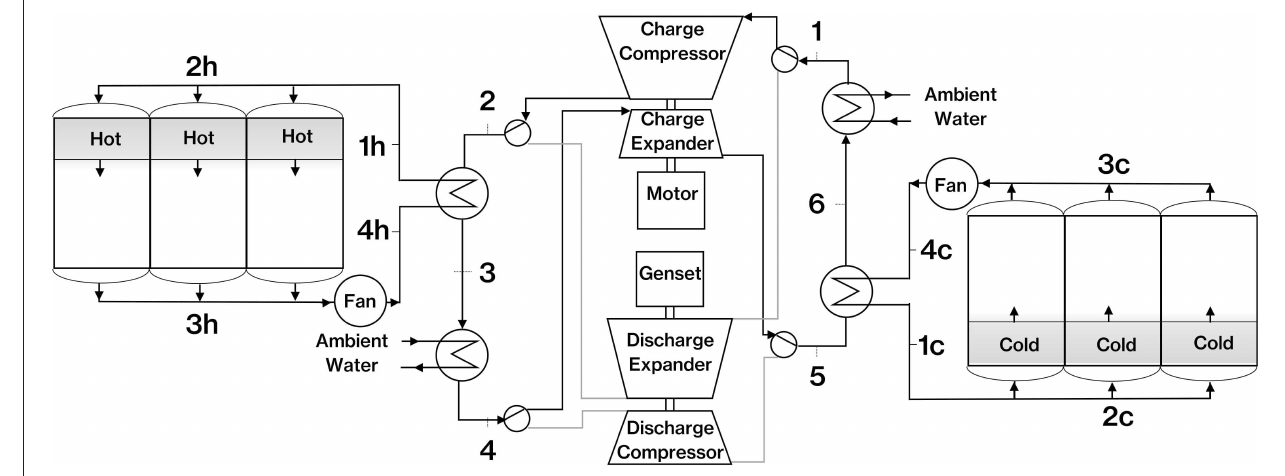
FIGURE 3 | De-coupled PTES system in charge mode.